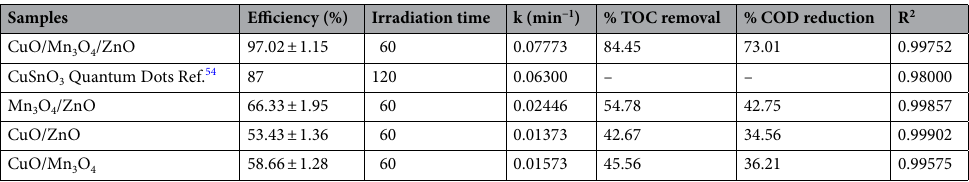
Table 2. Photodegradation chart over different catalyst systems.